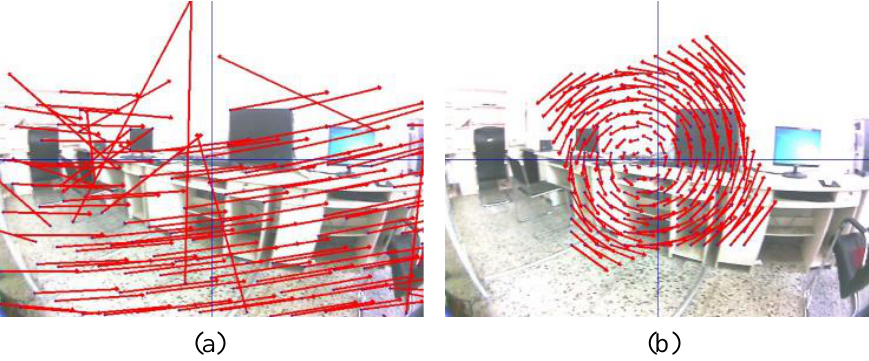
Figure 6. The motion flow at 𝜔 𝑧𝑐𝑎𝑚 = −2 .82 rad/s ( a ) a KLT tracker and ( b ) an IMU-aided motion estimator.